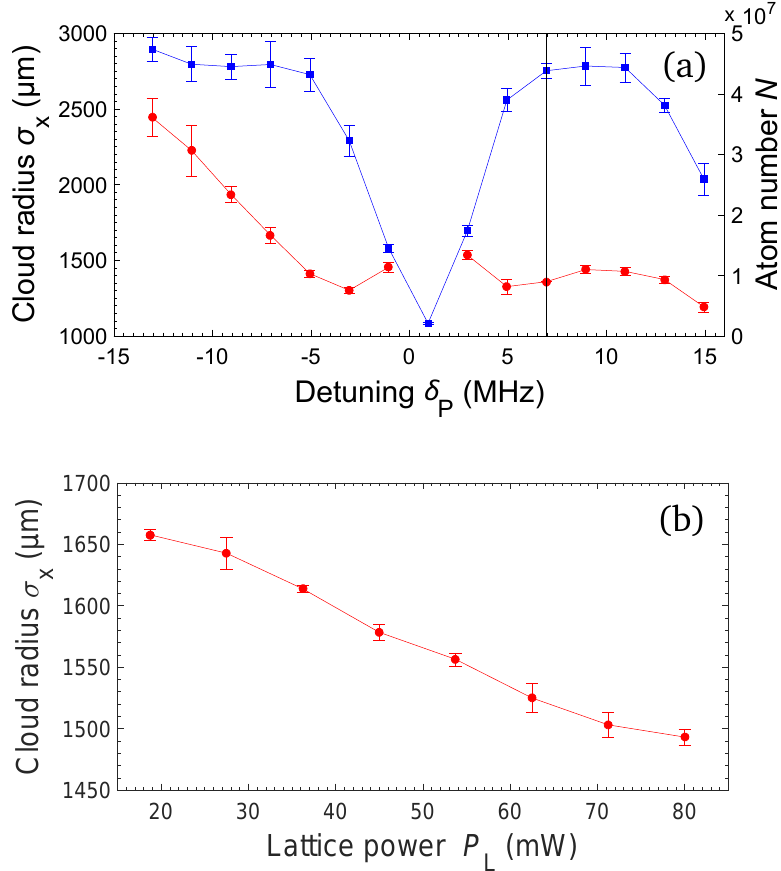
Figure 5: (a) Cloud radius σ (red circles) and atom number (blue squares) post X = cooling as a function of the polarizer detuning δ . We use a total lattice power P P L 80 mW, a polarizer intensity of 2.9 mW / cm 2 corresponding to 115 µ W of power and a repumper power of 0.6 mW at -9 MHz detuning. (b) Cloud radius as a function of the total power in the three lattice beams. Polarizer and repumper parameters are the same as in (a) except that the polarizer detuning is kept at 6.9 MHz (vertical line). Error bars indicate standard deviations in both (a) and